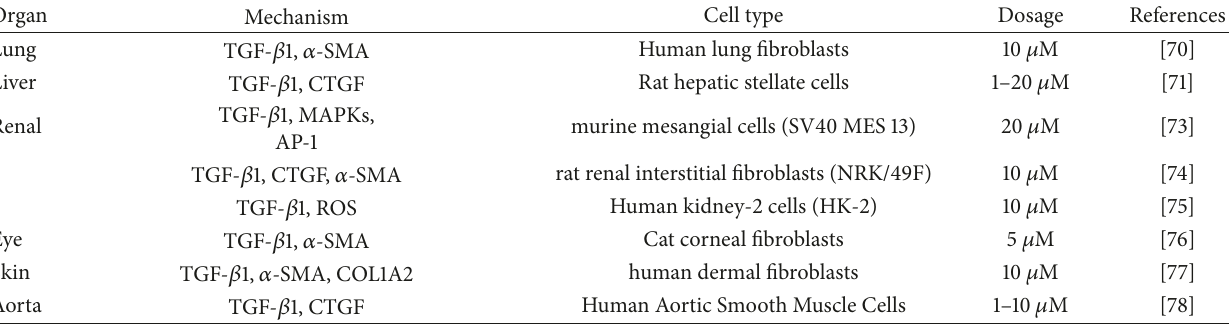
Table 3: Anti-fibrotic activity of